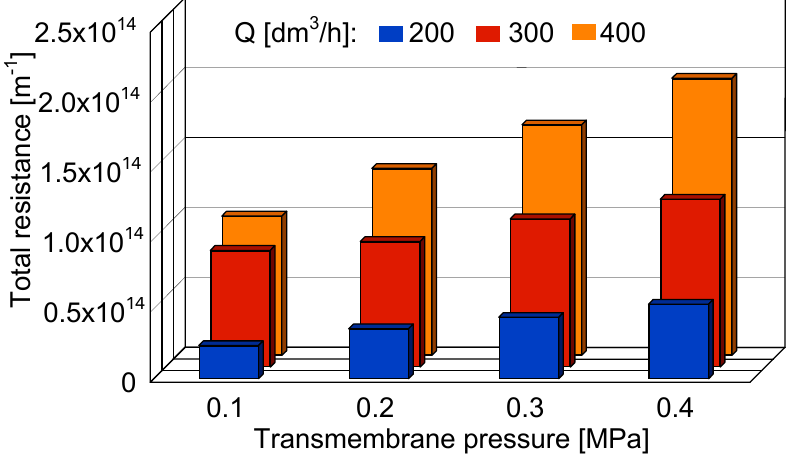
Figure 7. The impact of transmembrane pressure and feed flow rate on the total resistance.